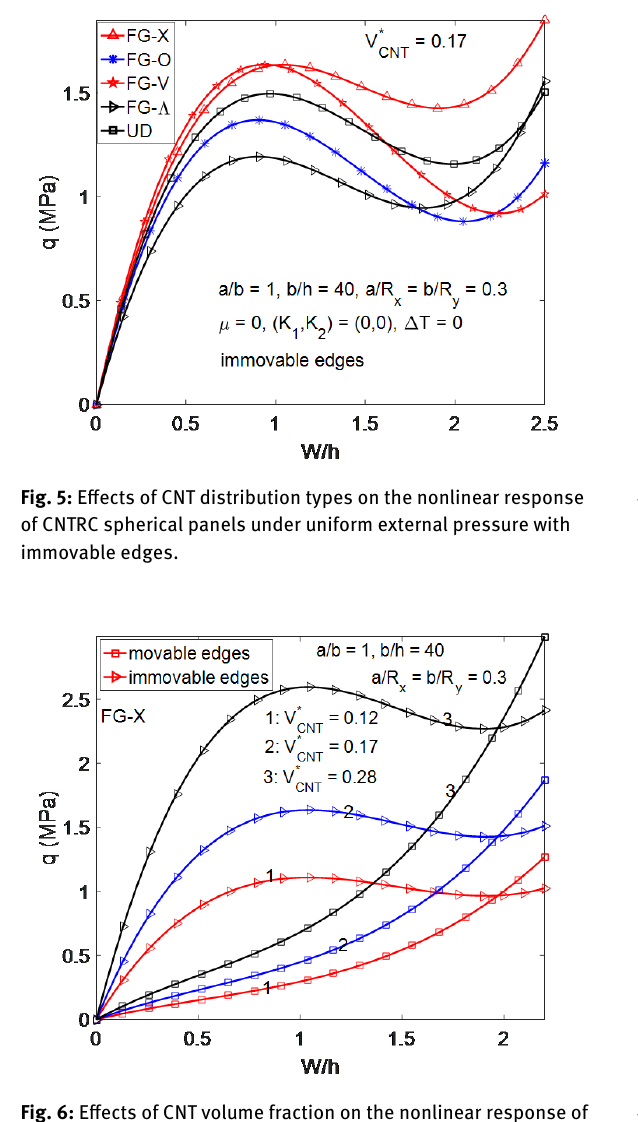
Fig. 6: Effects of CNT volume fraction on the nonlinear response of CNTRC spherical panels under uniform external pressure.